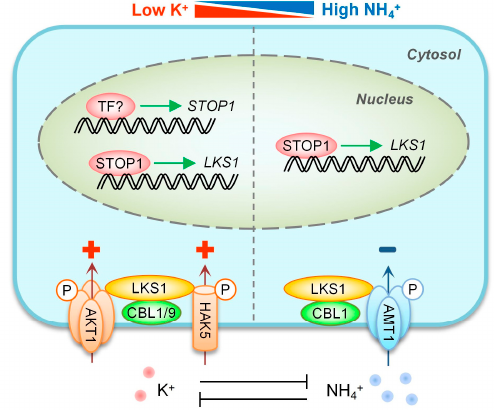
Figure 10. Working model of LKS1 transcriptional regulation by STOP1 in Arabidopsis response to low-K + and high-NH 4+ stresses. Low K + , rather than high NH 4+ , can upregulate the transcript level of the STOP1 gene. Both stresses result in STOP1 protein accumulation in the nucleus, where STOP1 activates LKS1 transcription. Subsequently, LKS1 promotes AKT1-/HAK5-mediated K + uptake and inhibits AMT1-mediated NH 4+ uptake. The details of this schematic model are described in the text. “P” represents the phosphorylation process; “+” and “ − ” indicate positive and negative regulation, respectively.